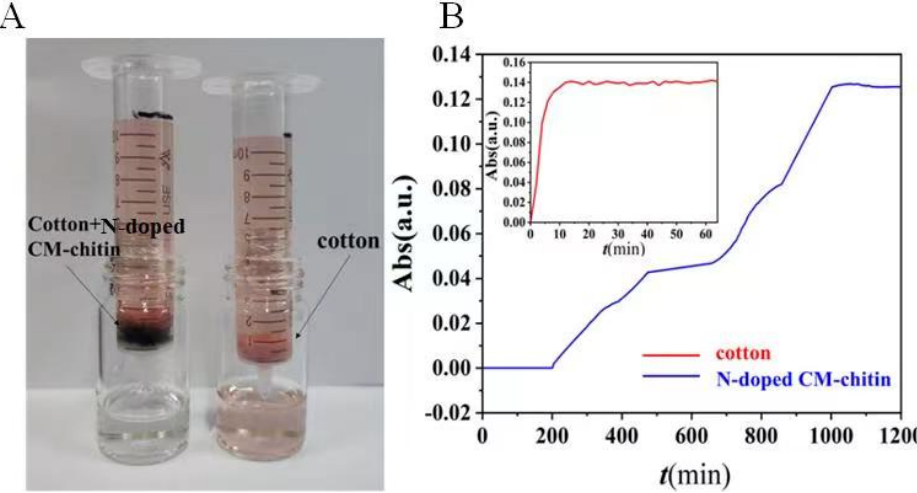
Figure 8. Optical photograph of the dynamic removal of CR (20 mg L − 1 ) by cotton + N-doped CM-chitin and cotton ( A ). Breakthrough curves of cotton and N-doped CM-chitin ( B ).